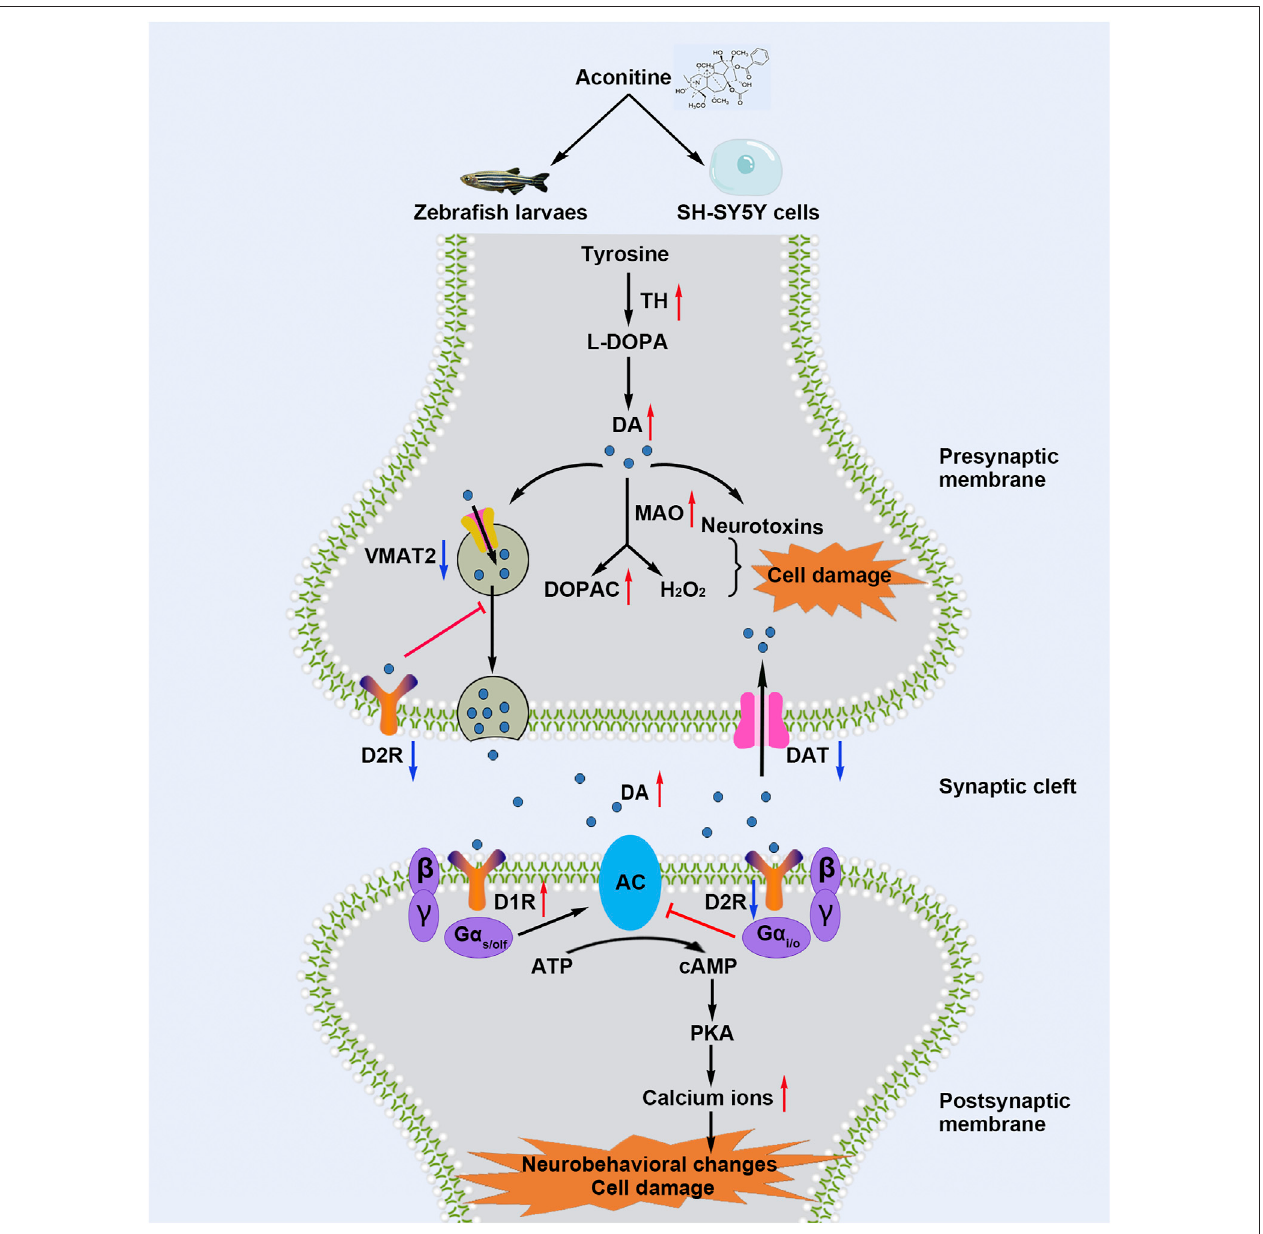
FIGURE 9 | Schematic diagram shows that aconitine induces neurological impairment via dopamine homeostasis disruption and dopamine receptors-mediated AC/cAMP/PKA pathway activation in zebra fi sh larvaes and SH-SY5Y cells.